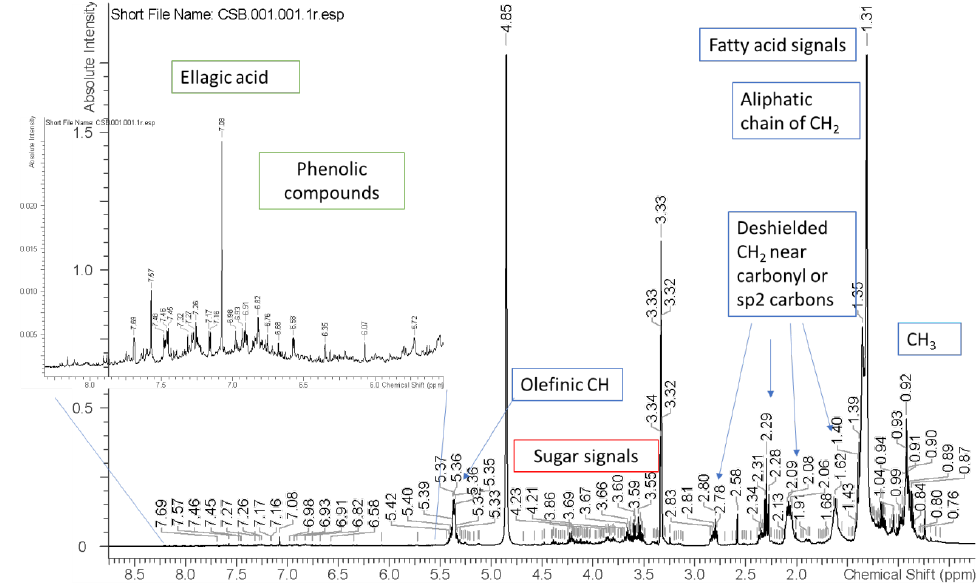
Figure 2. 1 H NMR of the optimal extract recorded in D 2 O.